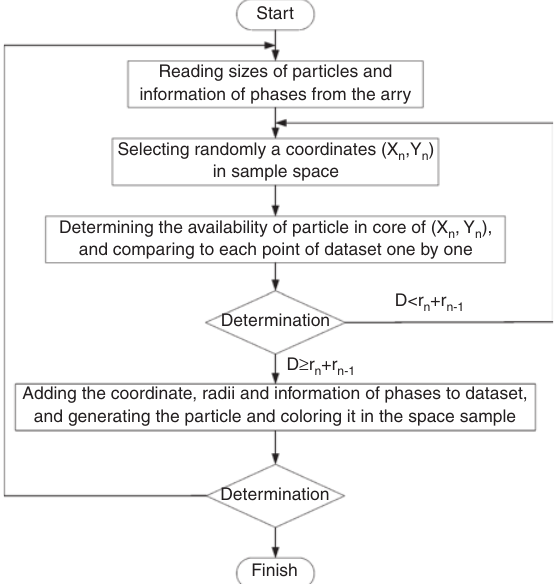
Figure 2: Flow chart for numerical simulation about air-entraining process. (Note that D represents the center distance between two particles and r is radius of particle n.) n